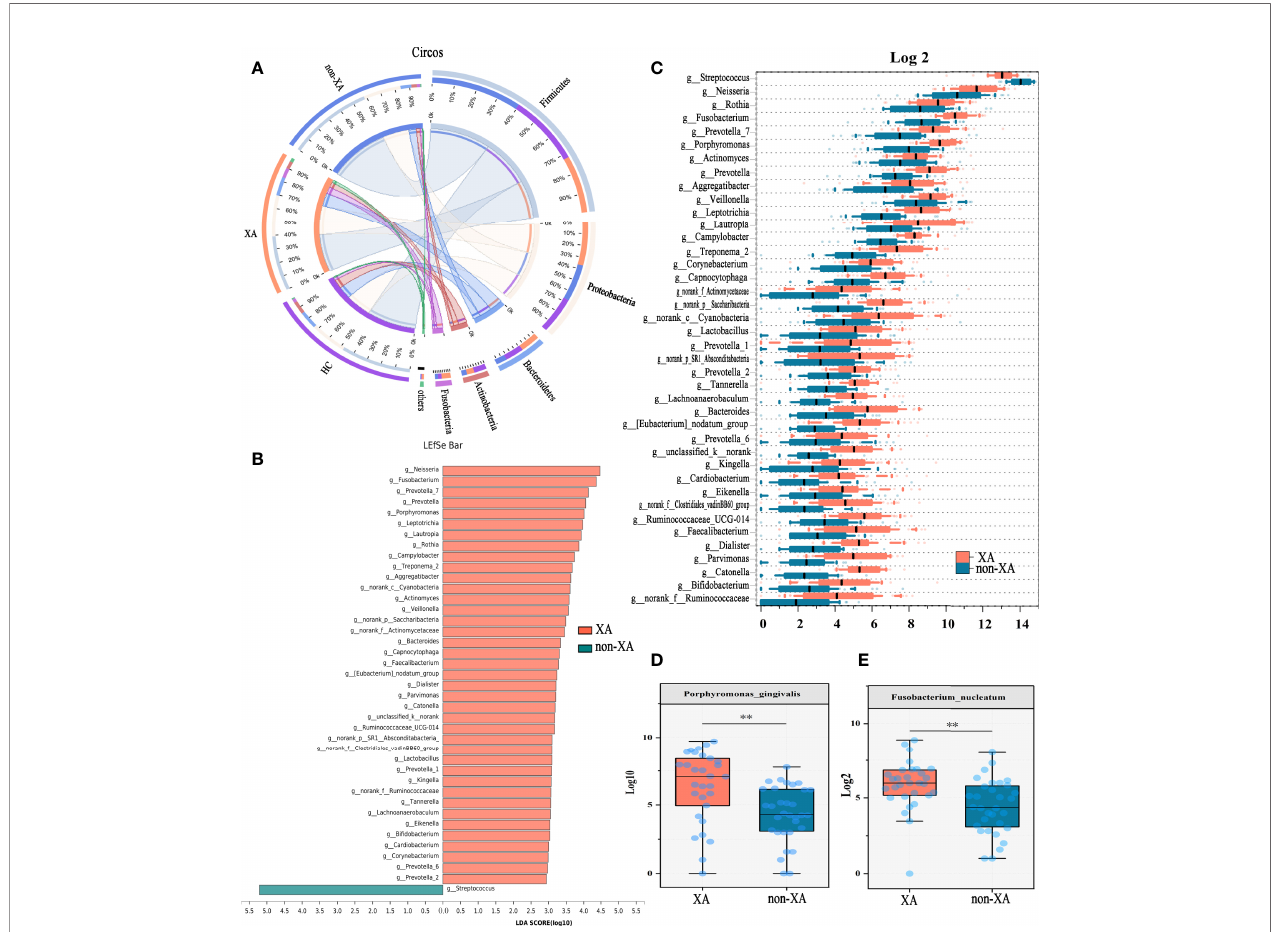
FIGURE 2 | Oral microbial phylotype variation at phylum, genus, and species levels. (A) The Circos plot was applied to demonstrate differences in phylum-level microbial composition among the three groups. The inner-circle on the left represented the microbial structural composition at the phylum level of each group. The outer circle on the left represented different groups. The outer circle on the right represented the percentage of phylum in different groups. The width of the bands represented the proportion or relative abundance of the phylum. (B) Species with the most signi fi cant differences between XAs and non-XAs were identi fi ed using LEfSe analysis based on the non-parametric factorial Kruskal-Wallis sum-rank test. XAs-enriched genera were shown in pink and non-XAs-enriched genera were shown in light blue. Genera with LDA values greater than three were reserved. (C) At the genus level, genera signi fi cantly different between XAs, and non-XAs were compared by Mann-Whitney U-tests (P < 0.05). At the species level, porphyromonas gingivalis (D) and fusobacterium nucleatum (E) were enriched in XAs compared to non-XAs. LEfSe, Linear discriminant analysis Effect Size (LEfSe); LDA, linear discriminant analysis; XAs, Xerostomia patients; non-XAs, patients without xerostomia; HCs,